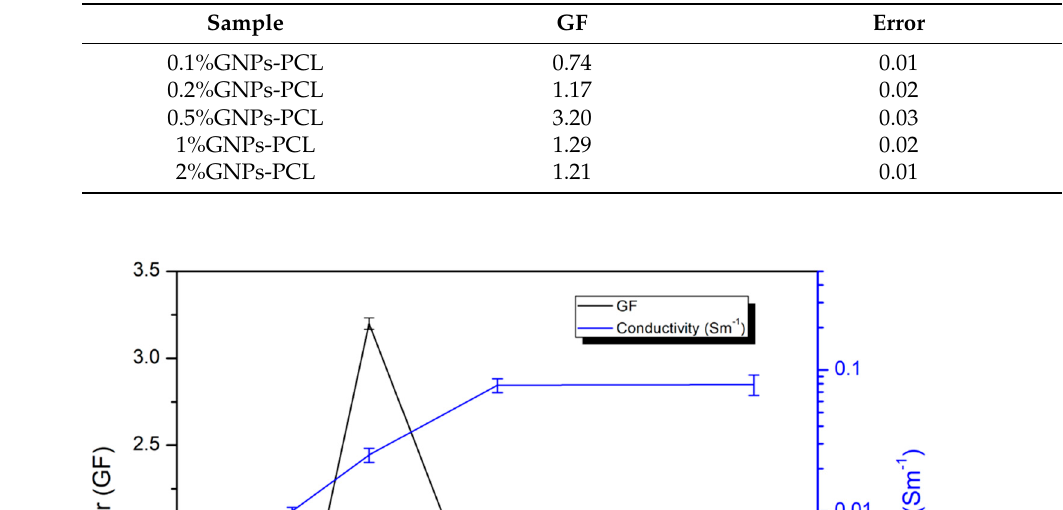
Table 3. Average Gauge Factor (GF) values obtained for each sample.